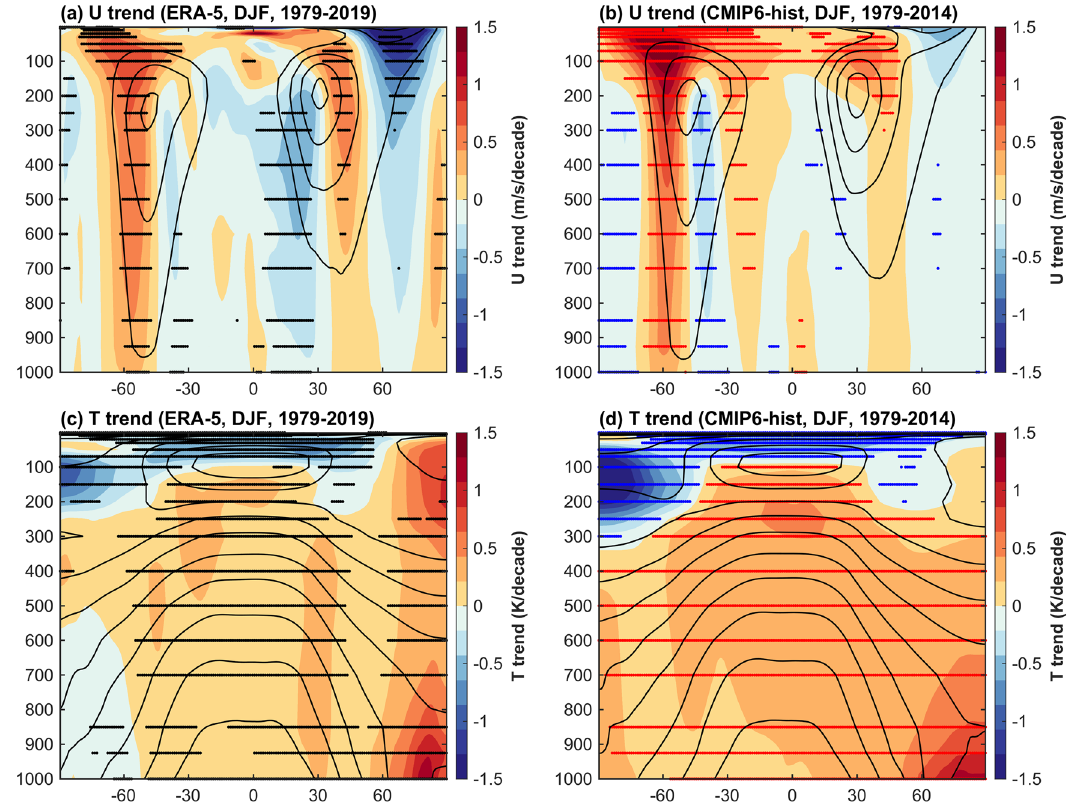
Fig. 1 Linear trends in DJF zonal mean zonal wind and temperature as a function of latitude and pressure from ERA5 and the CMIP6 historical simulations. ( a ) and ( c ) show the wind and temperature respectively from ERA5, and ( b ) and ( d ) show the same for CMIP6. Black dots in the ERA5 panels indicate signi fi cance at the 5% level using a T-test. Red and blue dots in the CMIP6 panels indicate that 75% of models agree on the sign of the trend, positive or negative, respectively. Solid lines mark the climatologies with intervals of 10 m s − 1 and